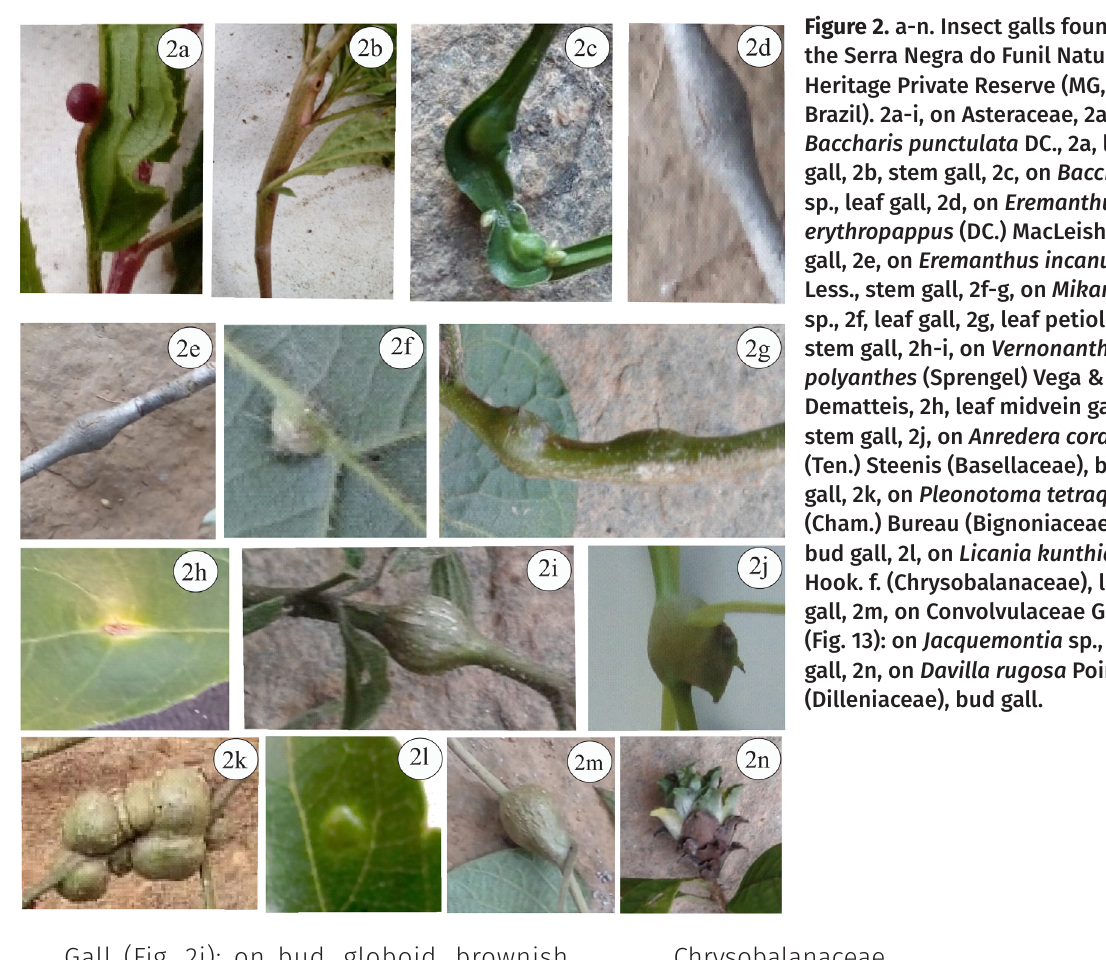
Gall (Fig. 2l): on leaf, lenticular, green, glabrous, one-chambered. Gall-inducer: not determined. First gall record on this host. Several authors have been recorded galls on other species of this genus in PA (Almada & Fernandes 2011, Maia 2011, Araújo et al. 2012), GO (Araújo et al. 2015), MG (Maia & Fernandes 2004, Coelho et al. 2013a, Maia 2014, Maia et al. 2014b), SP (Maia et al. 2008), Parque Nacional do Itatiaia (Maia & Mascarenhas 2017), RJ (Maia & Siqueira 2020), and MS (Ascendino & Maia 2018).